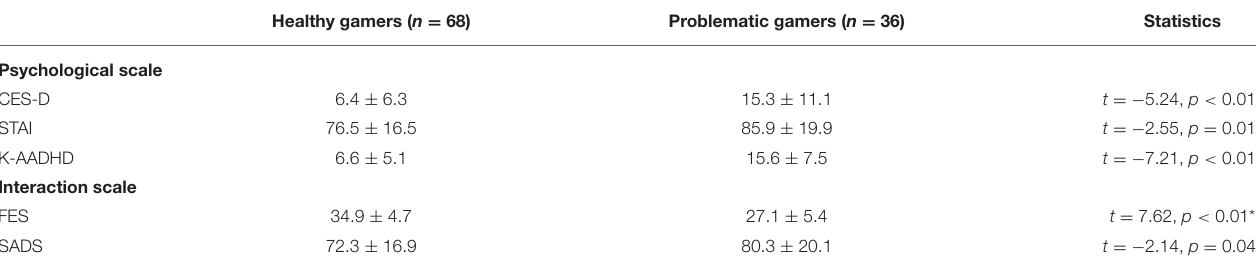
TABLE 2 | Comparison of scores on the psychological and social interaction